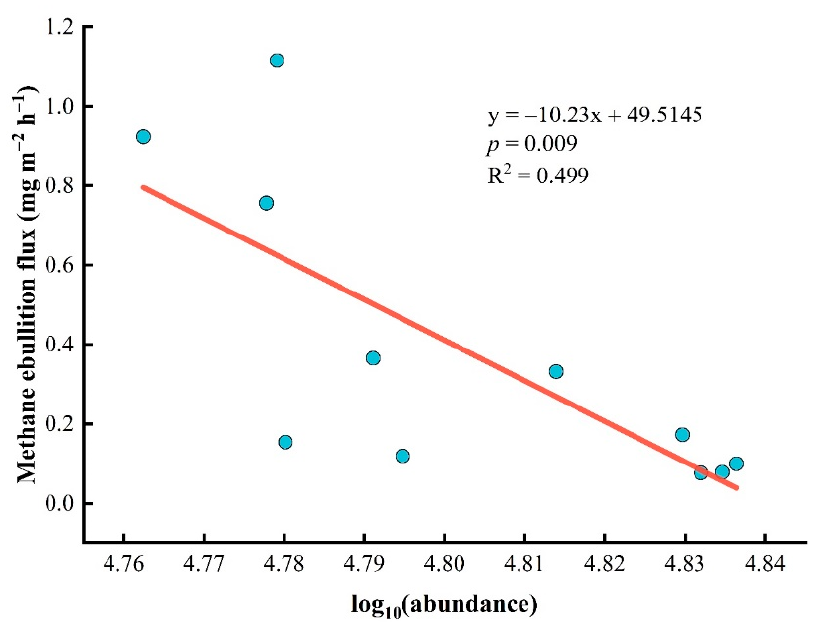
Figure 5. Regression analysis of CH 4 ebullition flux and the logarithm of microbial community abundance in sediments. The red line represents the fit of a linear regression through the observed data.